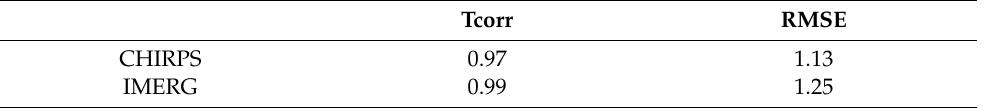
Table 2. Temporal correlation coefficient (Tcorr) and root mean square error (RMSE; unit: mm · d − 1 ) for comparison between time series of CWB and two SPPs given in Figure